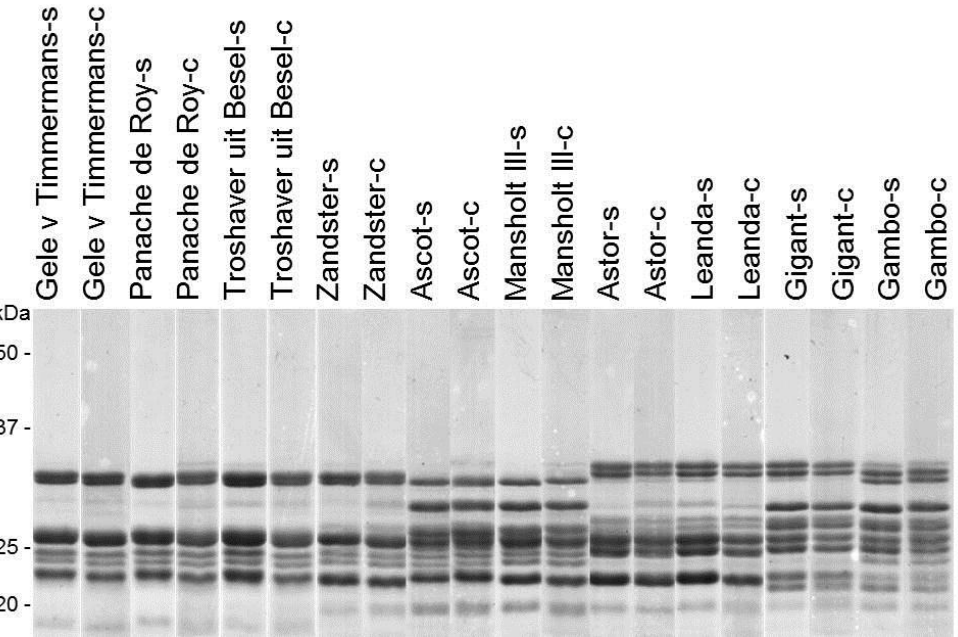
Figure 2. Avenin extracts (2 µ g) from ten oat varieties grown in sandy (s) and clay (c) soil separated by SDS-PAGE gels and stained with PageBlue™. Lanes were obtained from three SDS-PAGE gels run at the same time.